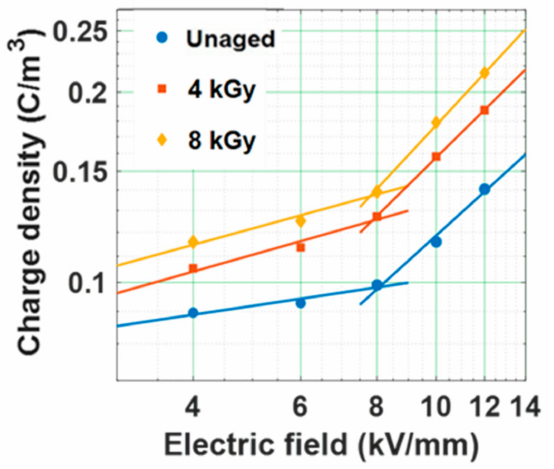
Figure 5. Average space charge density as a function of applied electric field in gamma irradiated samples